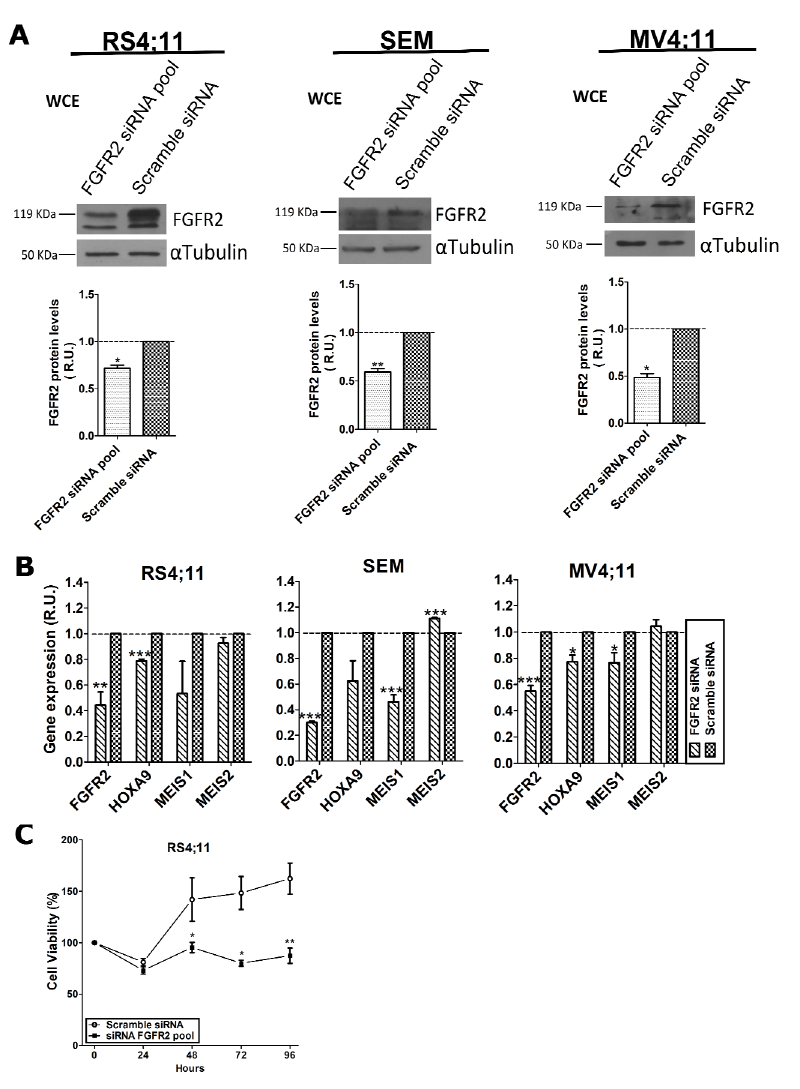
Figure 2. FGFR2 affects transcription of MLL-AF4 target genes in three t(4;11) cell lines. ( A ) Western blot analysis of total proteins (WCE) extracted 72 h after transfection with FGFR2-siRNA pool carried out with anti-FGFR2 antibody to evaluate residual FGFR2 amount; scramble siRNA represents the negative control; α -tubulin was used to normalize protein loading. ( B ) RT-qPCR analysis of FGFR2 , HOXA9 , MEIS1 , and MEIS2 transcript levels in FGFR2-silenced cells. Average values from at least three independent experiments are graphically reported as relative units (R.U.). Relative gene expression was normalized to ACTB, POLR2A , and TUBA1A genes and expression levels were determined using the 2 − ∆∆ Ct method. Statistical significance was calculated by one-way two-tail paired t -test. p -values are indicated as follows: * = p < 0.05; ** = p < 0.01; *** = p < 0.005. ( C ) Cell viability determined by MTT assay at 0, 24, 48, 72, and 96 h after transfection of cells with a FGFR2 siRNA pool and with scramble siRNA as a control. R.U., relative